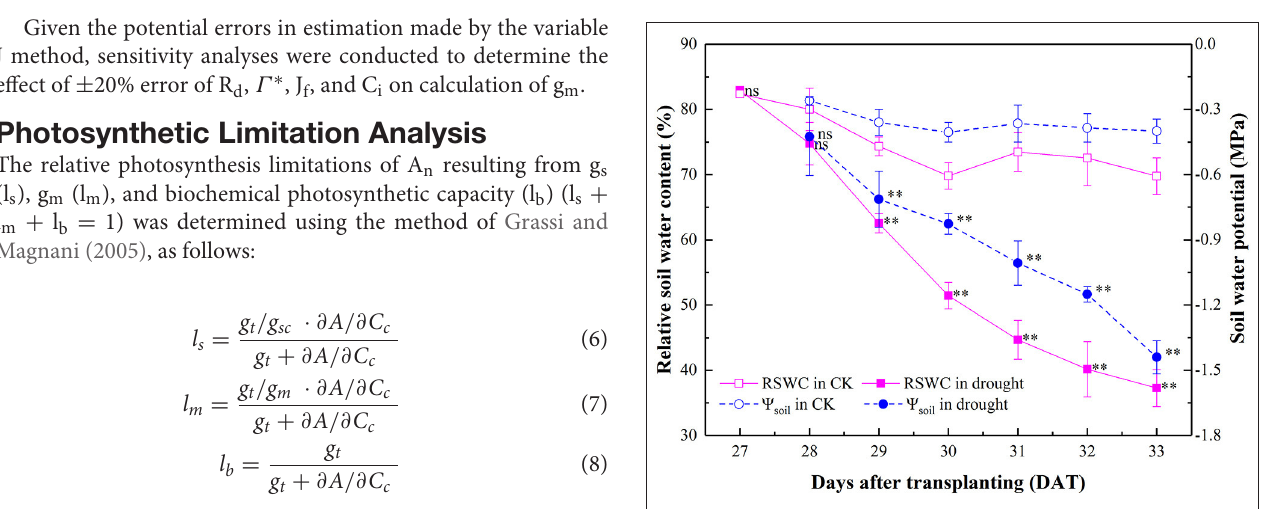
FIGURE 1 | Dynamics of RSWC and Ψ soil in the well-watered (CK) and drought-stressed tomato seedlings during 27–33 DAT. Mean values and SD were presented ( n = 6). ns indicated no significant difference and ** indicated significant difference at P < 0.01 level between drought and well-watered